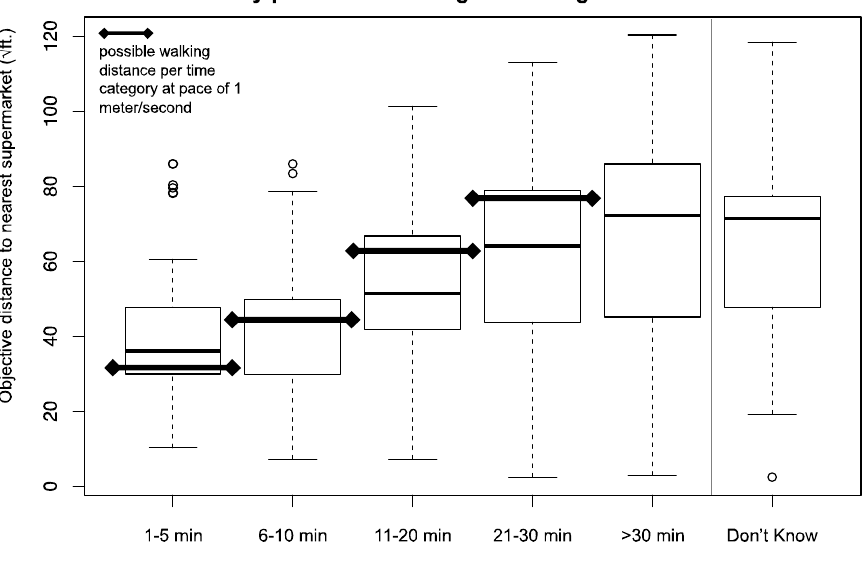
Figure 2. Boxplot of objective distance to the nearest grocery store and perceived walking time. Note: Distance presented as square root for ease of presentation, and lines with markers demarcate the possible distances traveled by walking for a given time at pace of 1 m/s. Table 3. Likelihood ratio tests for coefficients in the fully-adjusted multinomial model comparing participants categorized by accuracy of perceptions regarding distance to nearest supermarket.